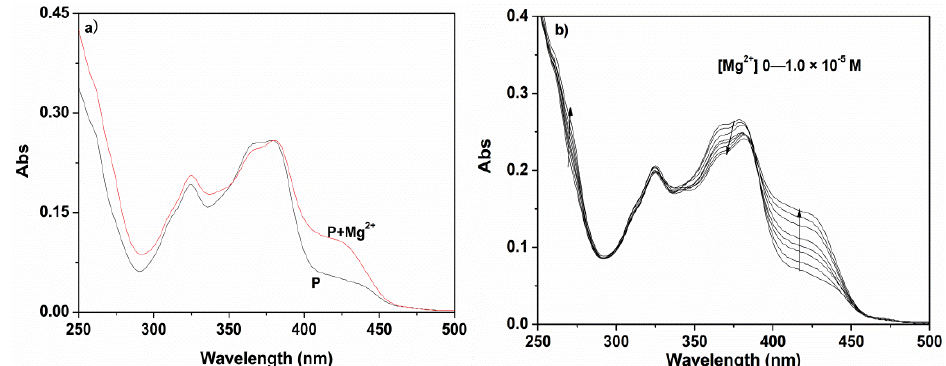
Figure 3. ( a ) UV-vis spectra of P (10 μ M) in water – ethanol solution (1:9, v : v , pH 10.0, 20 mM HEPES) with 10 μM Mg 2+ ; ( b ) UV-vis spectra of P (10 μM) with various concentrations of Mg 2+ in water – ethanol solution (1:9, v : v , pH 10.0, 20 mM HEPES).